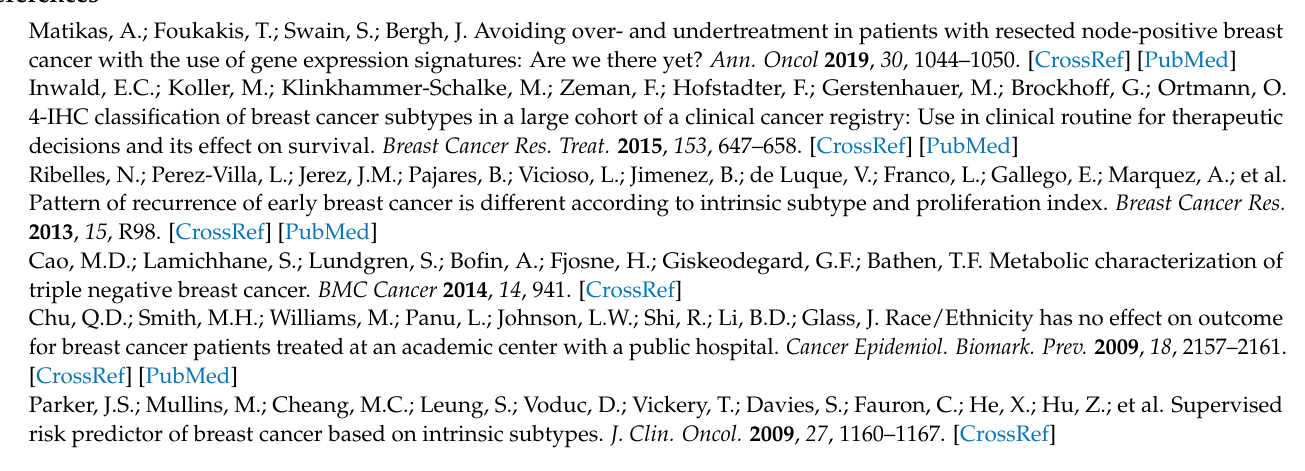
enrich subtype BC., Table S1: Spearman’s correlation analyses between O -GlcNAc and each of parameters, Table S2: Spearman’s correlation analyses between PKM2 and each of parameters, Table S3: Spearman’s correlation analyses between CTS5 and each of parameters, Table S4: Univariate Cox regression analysis to DFS, Table S5: Mutivariate Cox regression analysis of invasive tumor size, O -GlcNAc, and PKM2 for DFS, Table S6: Mutivariate Cox regression analysis of T stage, O -GlcNAc, and PKM2 for DFS, Table S7: Mutivariate Cox regression analysis of CTS5, O -GlcNA, and PKM2 for DFS, Table S8: Logistic regression analysis of CTS5, O-GlcNAc, and PKM2 for DFS, Table S9: Logistic regression analysis of invasive tumor size, O -GlcNAc, and PKM2 for DFS, Table S10: Logistic regression analysis of T stage, O -GlcNAc and PKM2 for